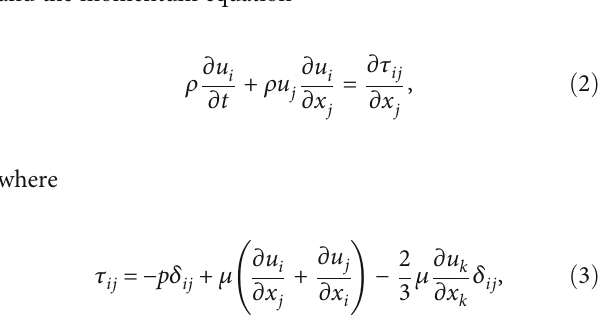
Figure 2: Homogeneous isotropic turbulence generated by a grid within a domain with source and observer